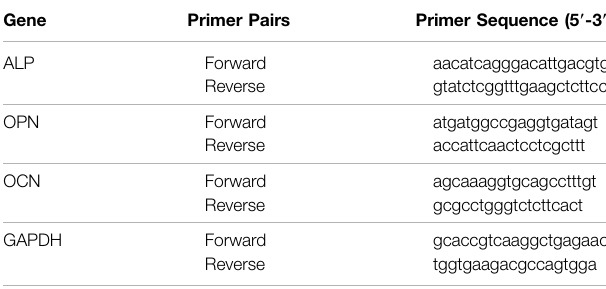
TABLE 2 | Primer sequences used for this